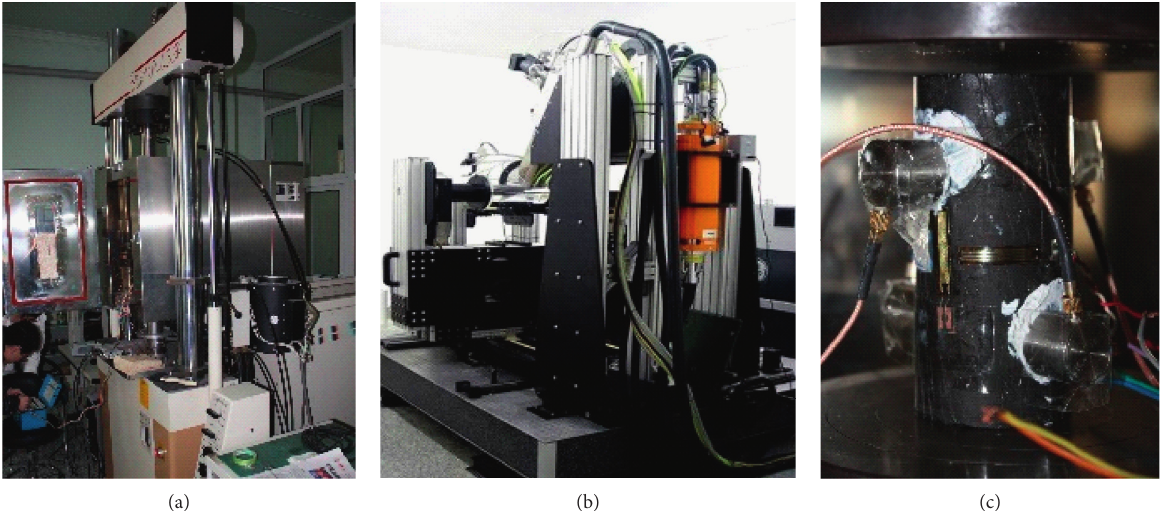
Figure 2: Experimental equipment and sample installation: (a) servo testing machine, (b) CT scanning equipment, and (c) acoustic